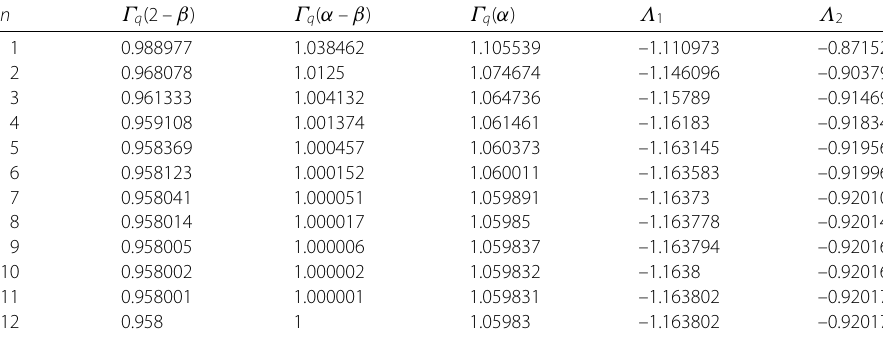
Table 4 Some numerical results for calculation of Λ 1 and Λ 2 with q = 1 Example 2